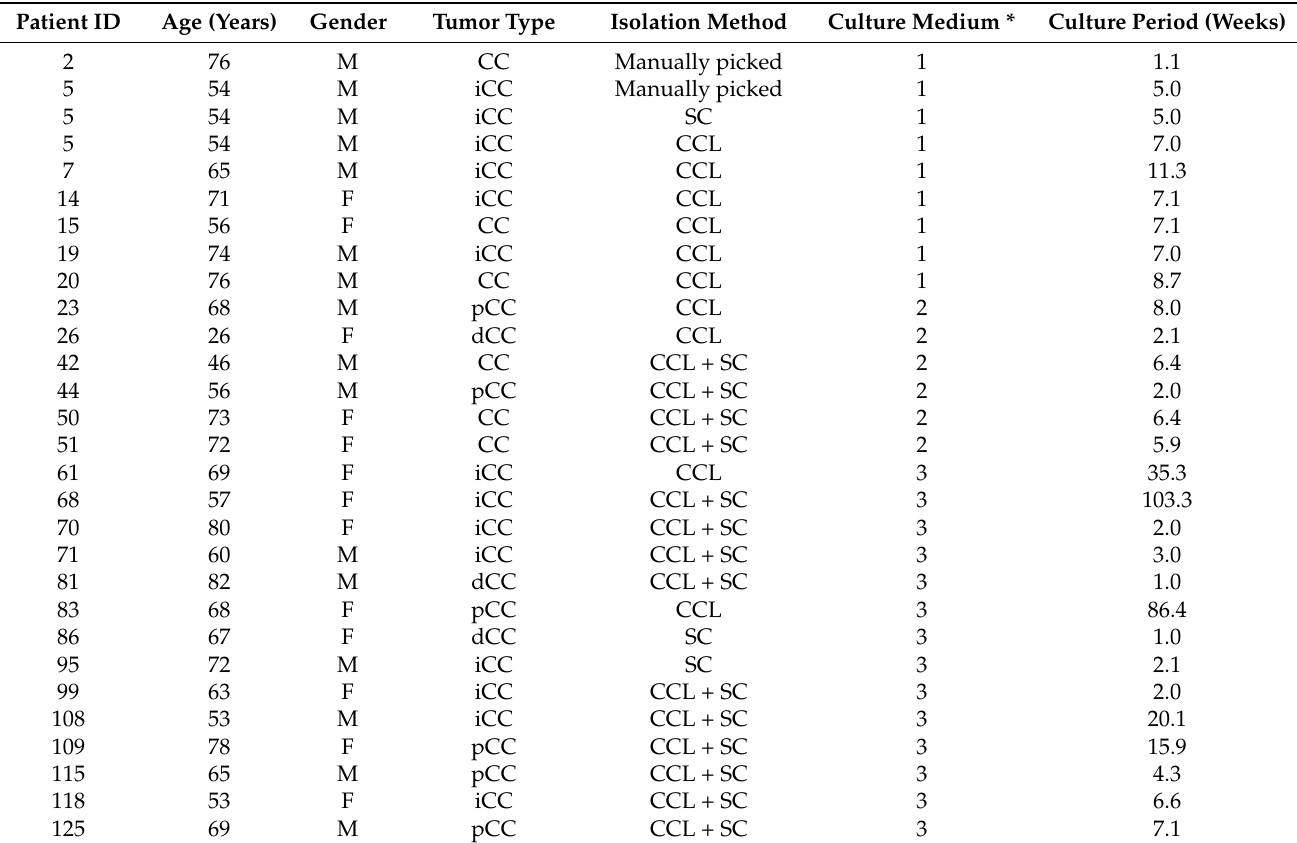
Table 1. Patient-derived organoid culture records of cholangiocarcinoma.